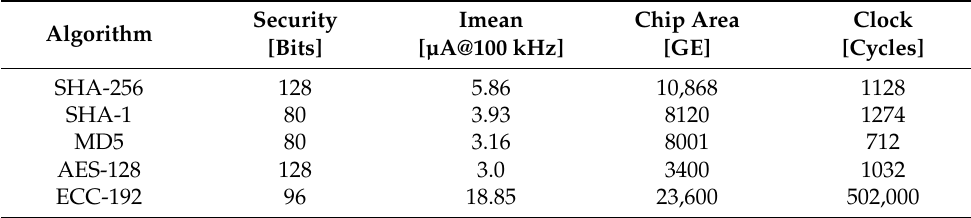
Table 2. Comparison of the cryptographic